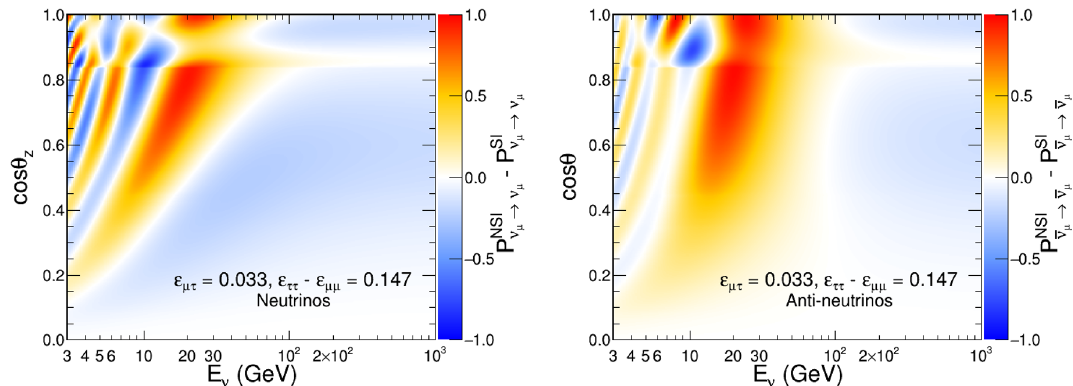
Figure 1 . NSI-induced modifications in ν µ (left) and ¯ ν µ (right) disappearance probabilities as a function of the true neutrino energy and cosine of the zenith angle. The NSI test point has been set at ( ε µτ , ε ττ − ε µµ ) = (0 . 033 , 0 . 147) . Normal mass ordering is